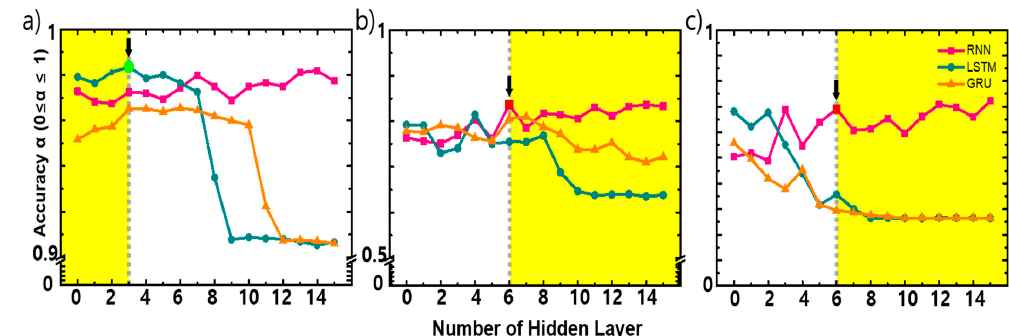
Figure 8. Accuracy result of the prediction of number of hidden layers: ( a ) CONSTANT, ( b ) EVENT 1, ( c ) EVENT 2. The yellow region indicates the optimized number of hidden layers of each situation. To save computation resources, the marked (with arrow) number of hidden layers are recommended.